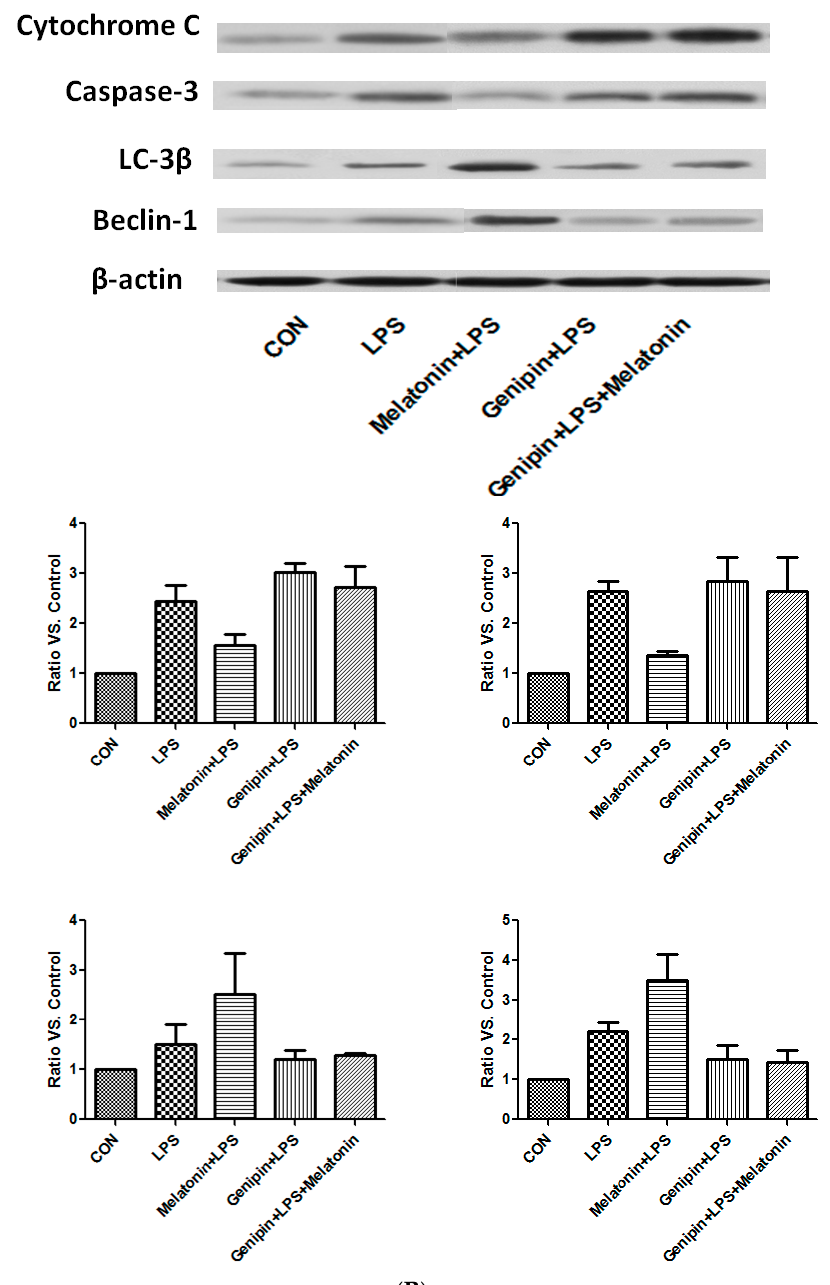
Figure 8. Effect on the expression of apoptosis-associated proteins and autophagy-associated proteins. Panel ( A ): Effect on proteins in the heart tissues of different groups of animals. Panel ( B ): Effect on the proteins in the cultured AC16 cells treated with indicated reagents.